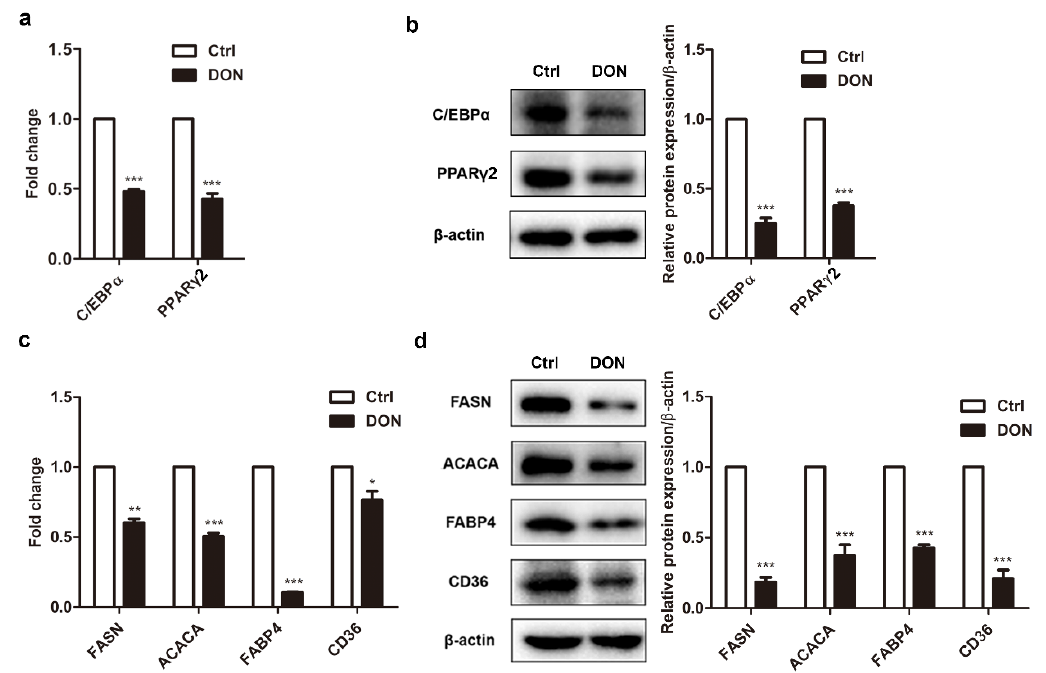
Figure 2. The effect of DON on the expression of adipogenic marker genes in 3T3-L1 cells. 3T3-L1 adipocytes were treated with 100 ng/mL DON during differentiation. The cells were harvested at the end of a 7-day differentiation. The expression of adipogenic marker genes was quantified by RT-PCR and Western blotting. ( a , c ) C/ebpα , Pparγ2 , Fasn , Acaca , Fabp4 , and Cd36 mRNA levels in 3T3-L1 cells. ( b , d ) C/EBPα, PPARγ2, FASN, ACACA, FABP4, and CD36 protein levels in 3T3-L1 cells (left). Quantification of protein levels (right). The results are representative of three independent experiments, and statistical significance is indicated by * p < 0.05, ** p < 0.01, *** p < 0.001.